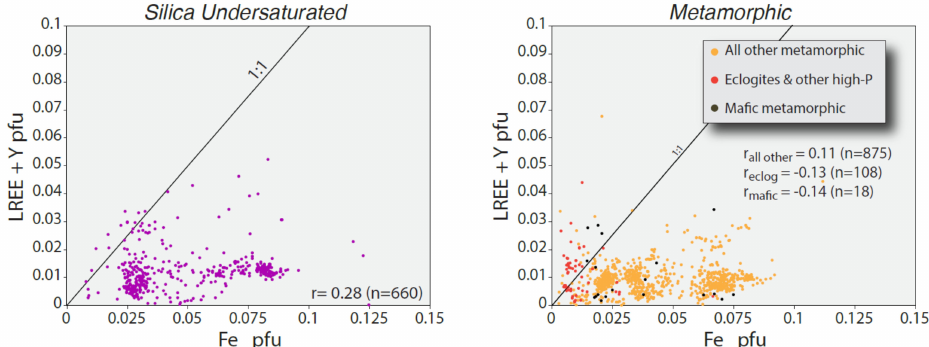
Figure 32. Fe versus LREE + Y in titanite from volcanic and plutonic rocks. The correlation coefficients (r) and number of analyses (n) in each group are shown.